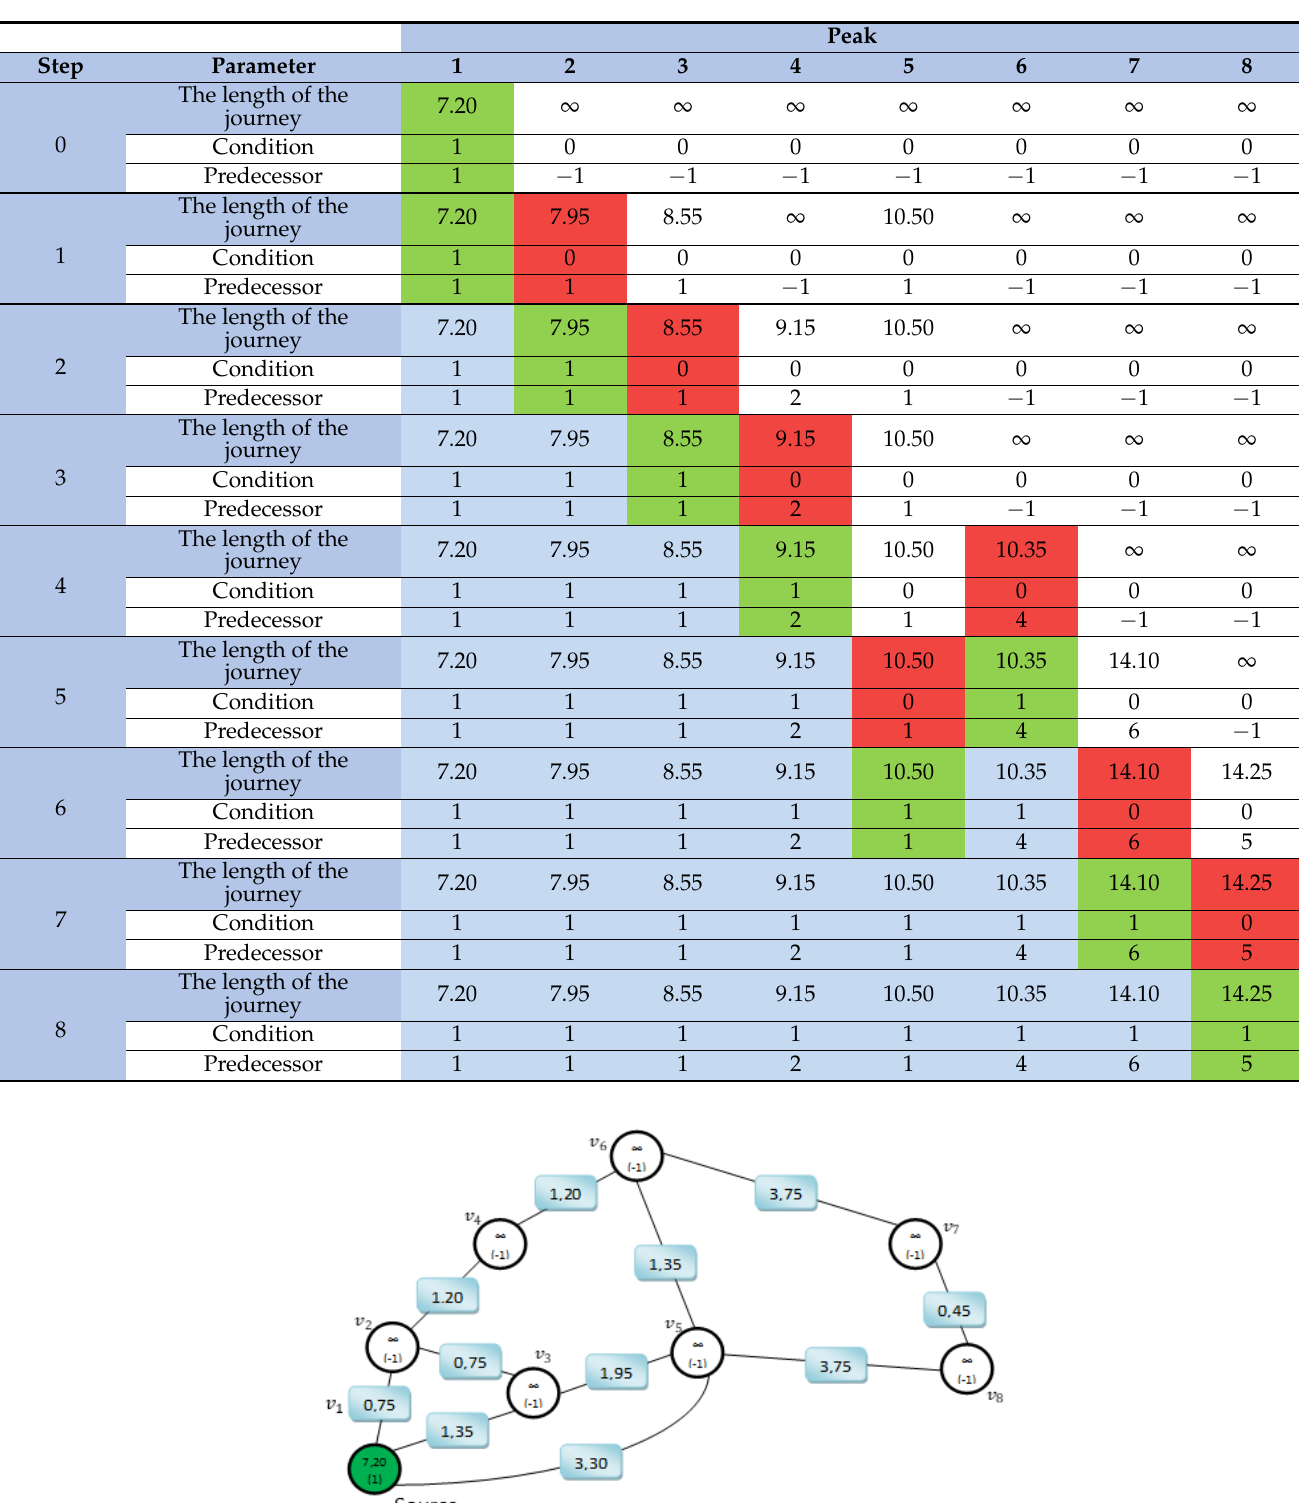
Table 3. Finding the optimal path from peak 1.